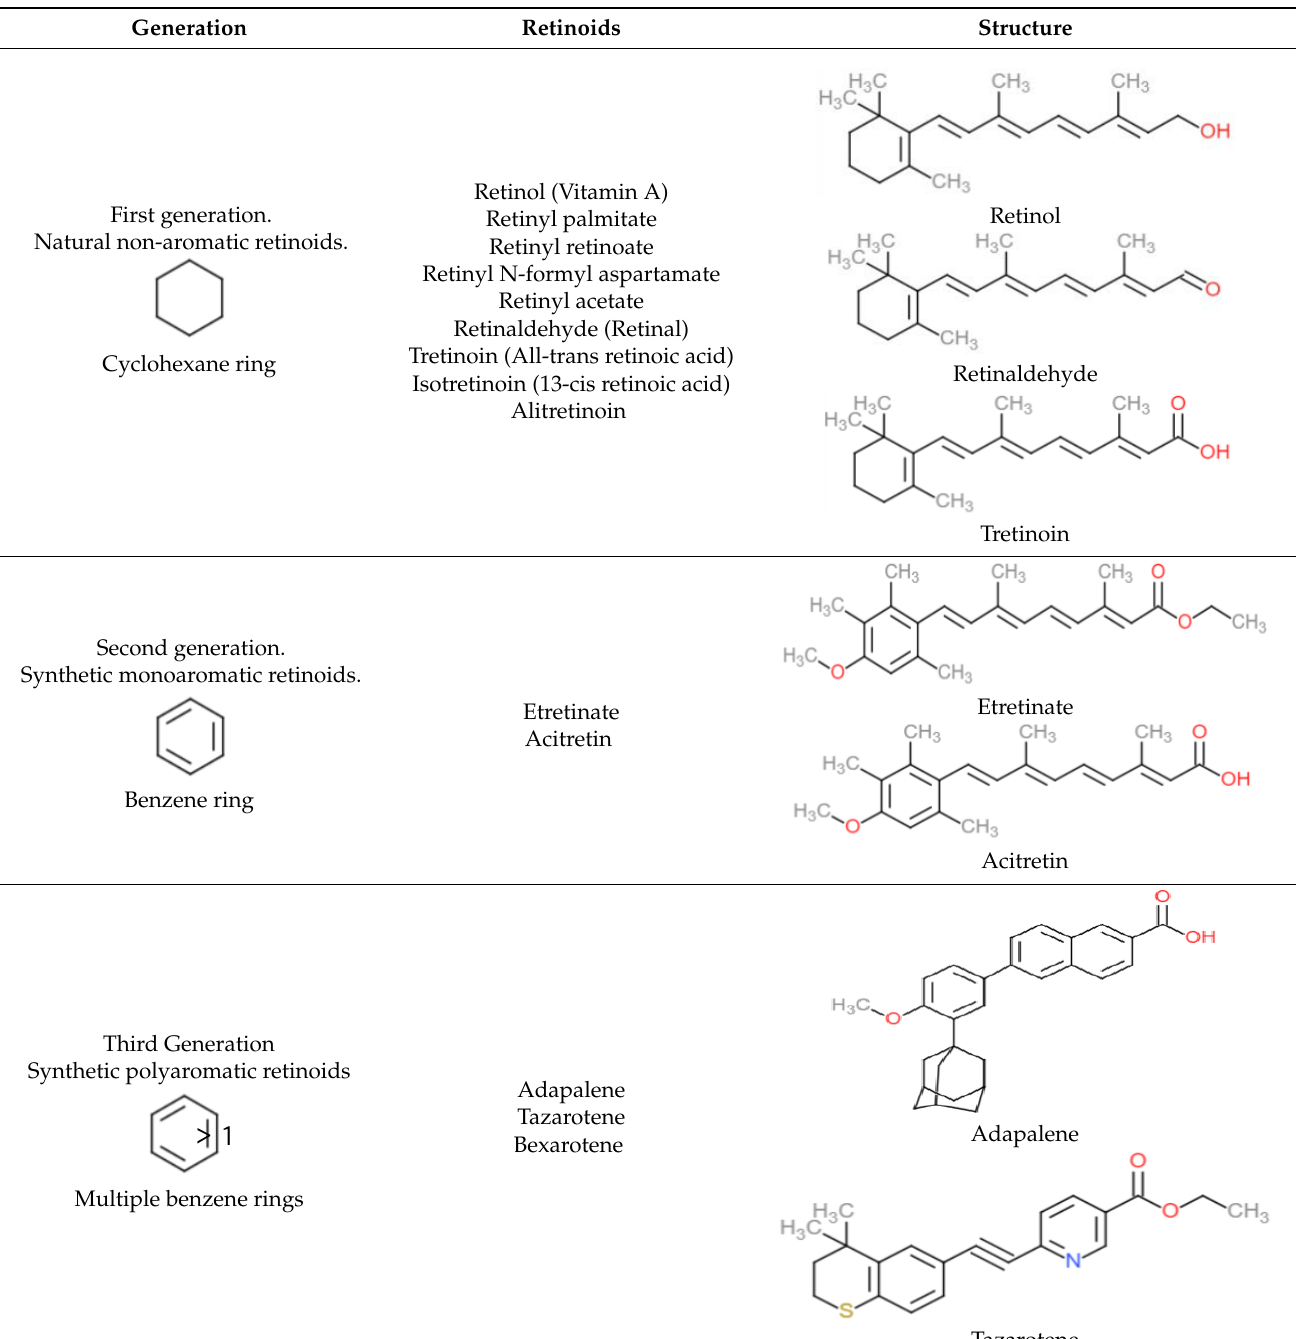
Figure 1. Retinoid structure (vitamin A). Table 1. Retinoid generations.